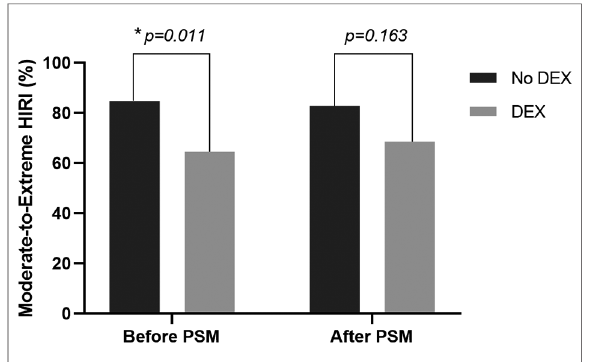
FIGURE 2 Comparison of the incidence of moderate-to-extreme hepatic ischemia-reperfusion injury (HIRI) between patients with and without intraoperative dexmedetomidine (DEX) before and after the propensity score matching (PSM) analysis. The p values were calculated using the Pearson ’ s chi-squared test. * p <0.05.